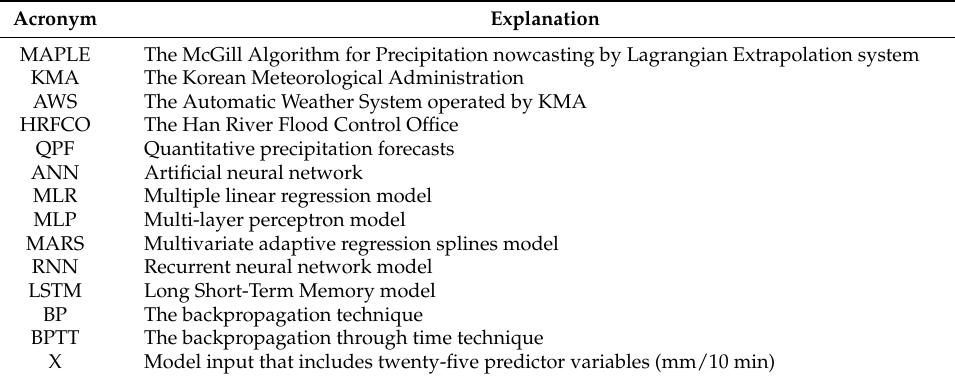
Table 1. The main acronyms utilized in this